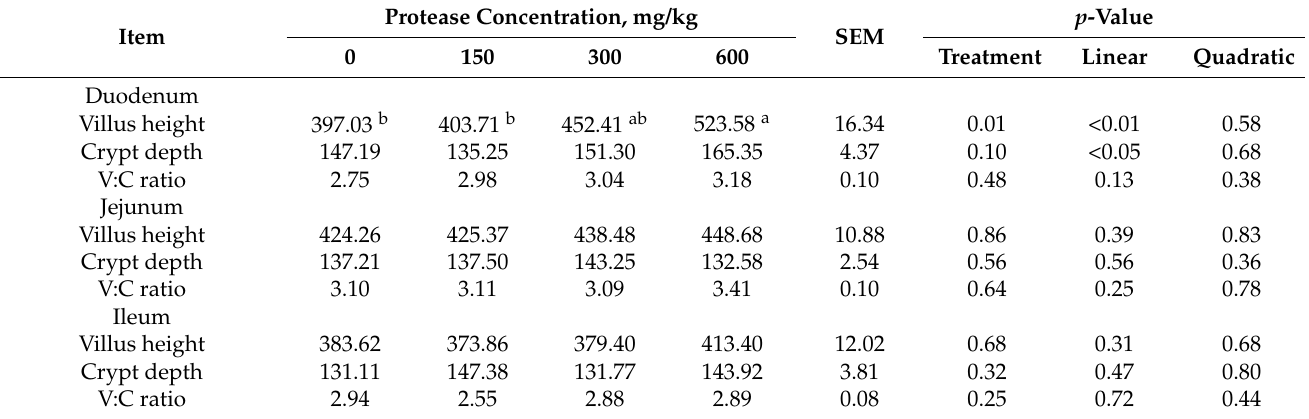
Table 8. Effects of protease supplementation on intestinal morphology in weaned piglets ( µ m).